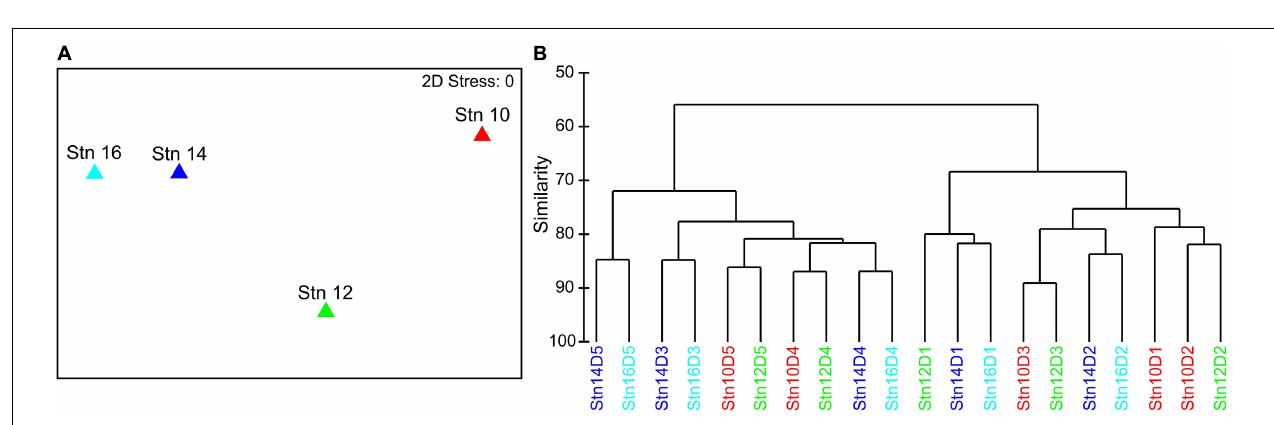
FIGURE 2 | Vertical distribution of total zooplankton abundance (ind. m − 3 , A ) and biomass (mg dry mass m − 3 , B ) across the submesoscale filament. Colors indicate the contributions of different taxa. Colored triangles indicate the location of the four stations (16, 10, 12, and 14) across the filament.